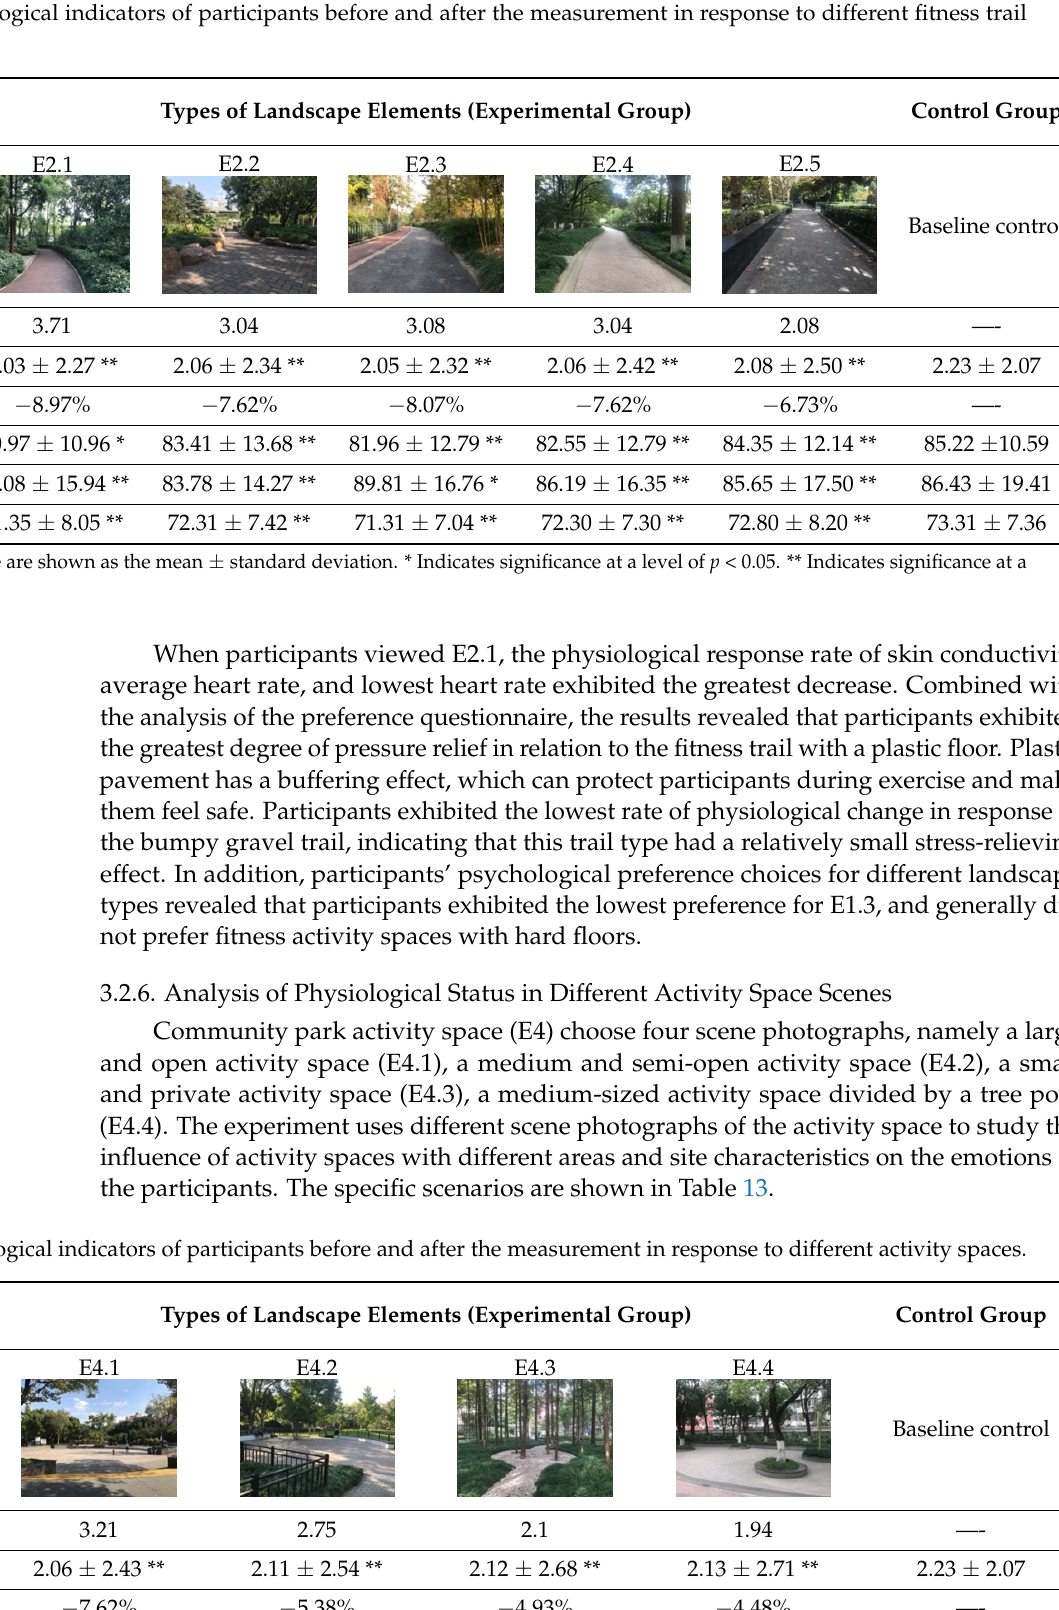
Table 12. Physiological indicators of participants before and after the measurement in response to different fitness trail spaces.